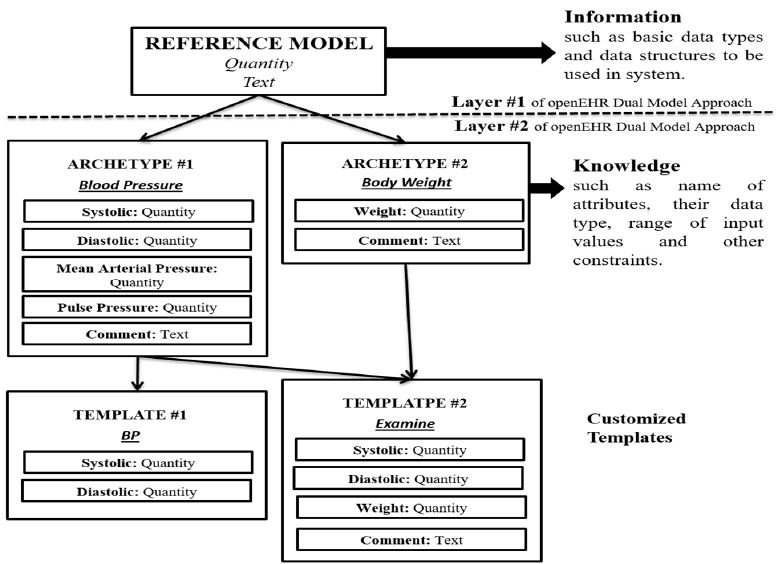
Figure 1. Dual model approach.